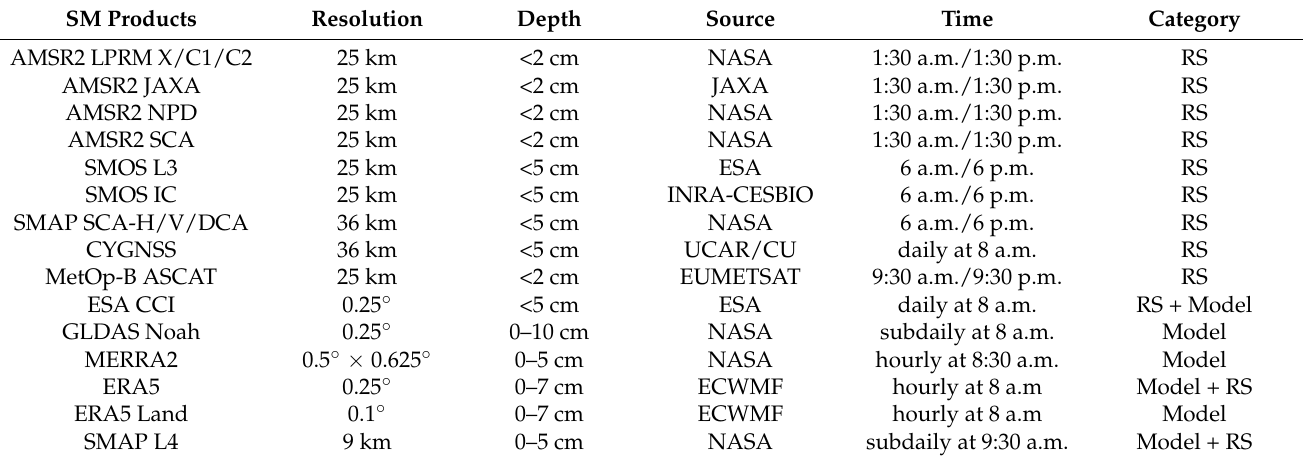
Table 2. List of soil moisture products used in this study. ‘RS’ and ‘Model’ mean that SM products are generated based on remote sensing or land surface modeling. ‘RS + Model’ means satellite retrievals plus rescaling to model outputs, and ‘Model + RS’ means assimilation of satellite retrievals into